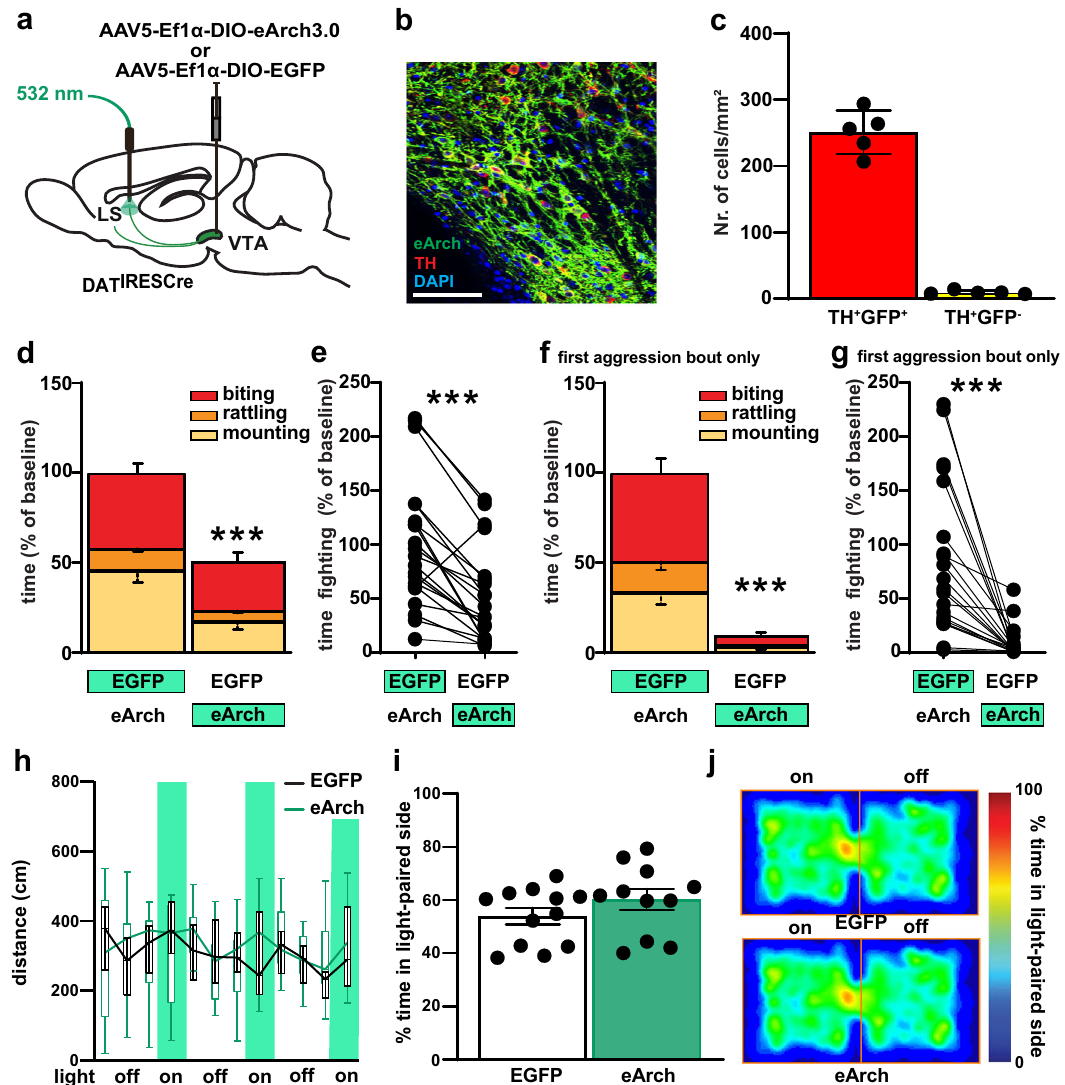
Fig. 6 Optogenetic inhibition in VTA → LS DAergic terminals impair aggressive behavior. a Schematic diagram for viral injection in DAT IREScre and terminal green light stimulation for optogenetic inhibition. b Representative image of cell type-speci fi c eArch3.0-eYFP expression (green) in VTA DA neurons (red), with colocalized neurons in yellow, scale bar (100 μ m). c Quanti fi cation of Arch expression in TH + neurons. d , e Inhibition (green) of LS DA terminals in DAT IRESCre mice by optogenetic stimulation of eArch reduced aggression behavior. f , g Inhibition (green) of LS DA terminals in DAT IRESCre mice by optogenetic stimulation of eArch abolished aggression behavior during the 55 s of light application triggered by the onset of the fi rst aggression bout. h No locomotion activity change was detected after LS DAergic terminal inhibition in the open fi eld, during alternating 3 min off and 55 s on (vertical green shading) bouts of continuous eArch stimulation. i During the RTPP task, the percentage of the time, over a 20 min session, spent in the stimulated zone was not signi fi cantly different between EYFP and eArch expressing mice. j representative heat maps of the time spent in the stimulated zone during RTPP. P < 0.01; *** P < 0.001 compared with their respective controls; mean ± SEM; n = 21 pairs, Box plots represent median and IQR and whiskers extend to maximum and minimum values ( h ). (Supplementary Data 1 for detailed